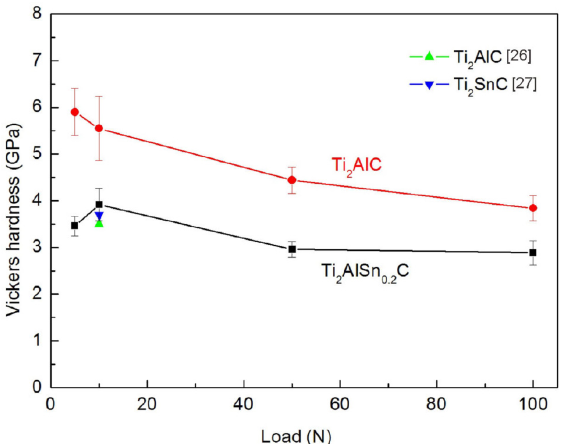
Fig. 4 Vickers hardness versus indentation load for Ti 2 AlC and Ti 2 AlSn 0.2